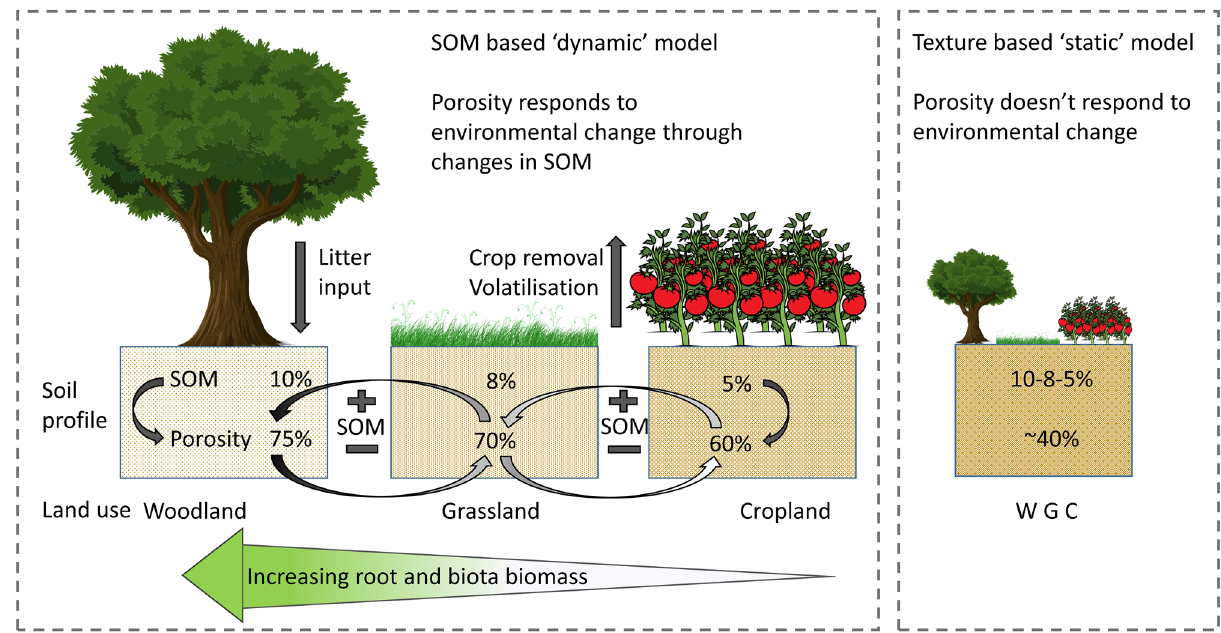
Figure 1. A conceptual diagram illustrating the proposed ‘dynamic’ relationship between topsoil organic matter (SOM), soil porosity and land use change, compared to the ‘static’ texture based view for the temperate UK system. High levels of SOM in broadleaf woodland result in a high porosity, transition to neutral grassland then cropland reduces the SOM and the respective porosity 36 . One might assume that it works the other way so that transition from cropland to grassland to woodland will in turn increase the porosity. While this is proposed for land use change, we would expect a similar change in soil porosity with SOM regardless of whether the change in SOM is caused by land use, management or climate change. The static view assumes no change in porosity with changing land use; W Woodland, G Grassland, C Cropland. Figure created by first author using